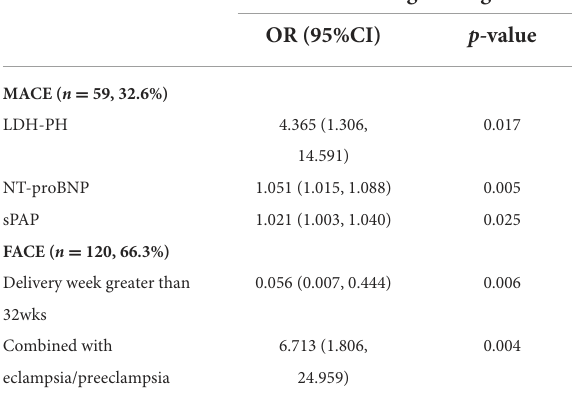
TABLE 5 Multivariable cox regression of risk factors for maternal mortality in pregnant patients with PH. Variable Multivariable cox regression